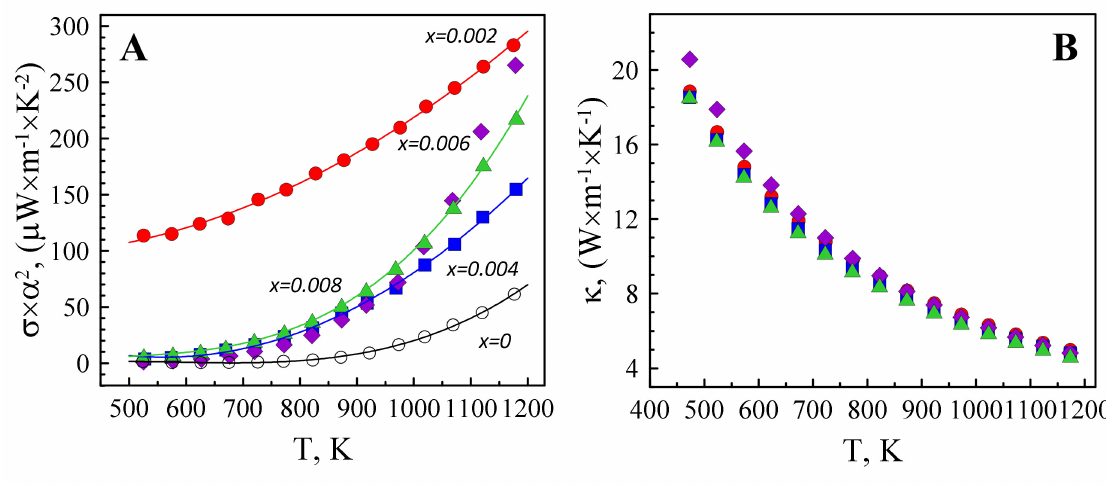
Figure 7. Temperature dependence of the power factor ( A ) and thermal conductivity ( B